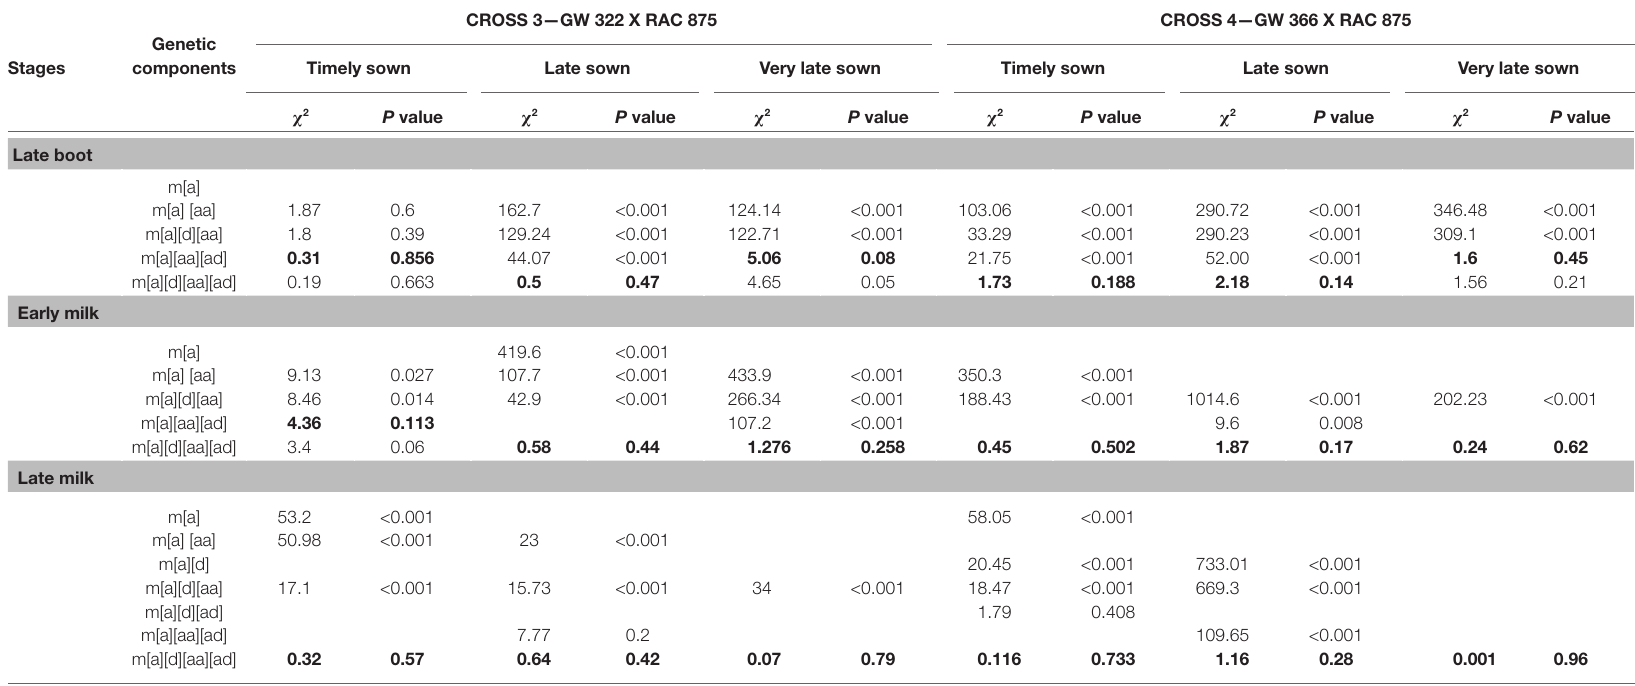
TABLE 5 | Chi-square and probability for goodness-of-fit test of appropriate genetic models for stomatal conductance in two crosses, GW 322 X RAC 875 and GW 366 X RAC 875, during three growth stages under timely, late, and very late sown condition.